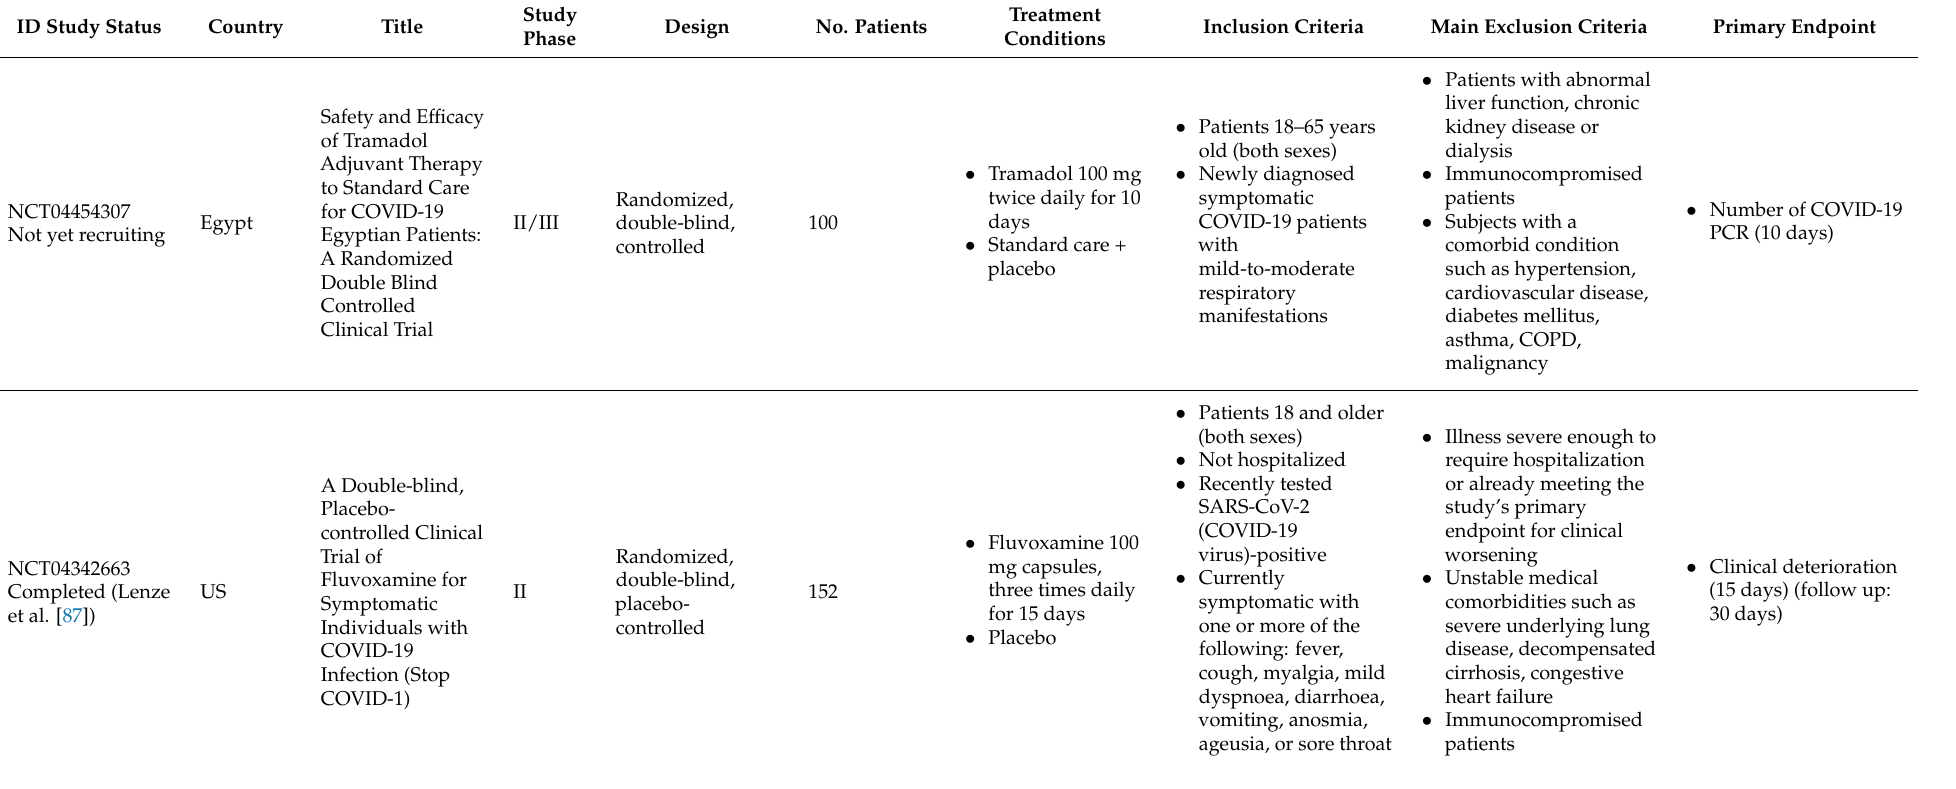
Table 1. Study characteristics of studies registered in CT databases using drugs with antidepressant activity in the treatment of COVID-19